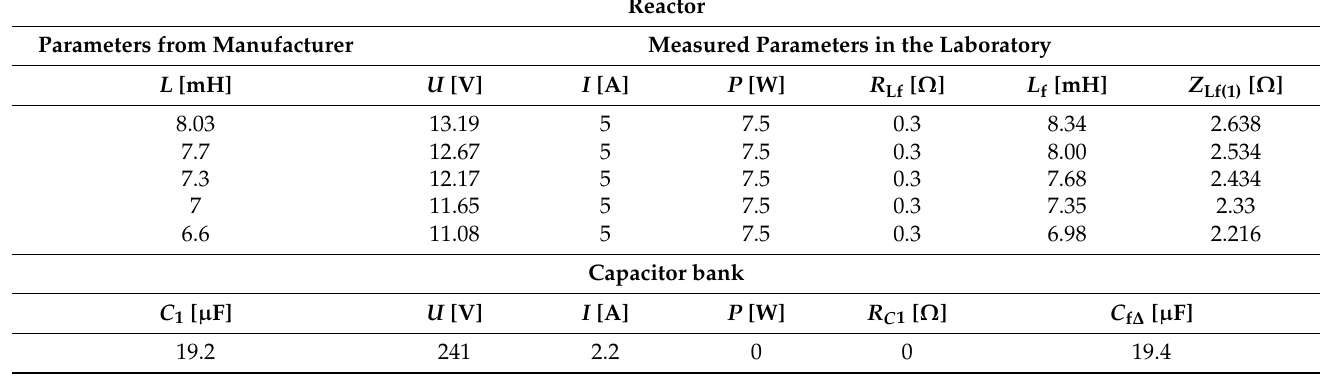
Table 3. The parameters of the filter elements from the manufacturer are compared to those measured in the